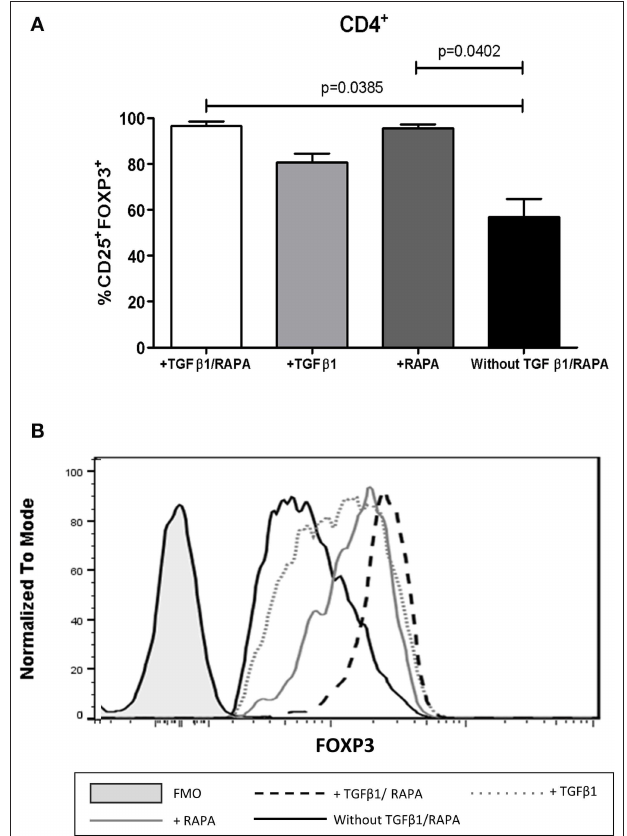
FIGURE 8 | Rapamycin is required to maintain the phenotype and expression of FOXP3 on expanded allospecific iTregs. Proliferating CD4 + CD25 ++ CTV − cells ( Figure 2 ) expanded for 6 weeks were stimulated for an additional week with four conditions: (1) with TGF- β and rapamycin (TGF- β + RAPA); (2) only TGF- β ( + TGF- β ); (3) only RAPA ( + RAPA); (4) absence of both TGF- β and RAPA (without TGF- β /RAPA). iTreg cells showed an altered proportion of CD25 + FOXP3 + (A) and FOXP3 expression (B) when TGF- β 1 and/or RAPA was removed from expansion cultures, and the presence of TGF- β 1 alone was not sufficient to maintain the regulatory phenotype. In contrast, RAPA was sufficient to maintain the percentage of CD25 + FOXP3 + Tregs and FOXP3 expression in the expanded iTregs. Data represent the mean ± SEM from n = 5 donors from three independent experiments. The statistical analysis was performed using the non-parametric Mann–Whitney test, two-tailed. P < 0.05 was considered statistically